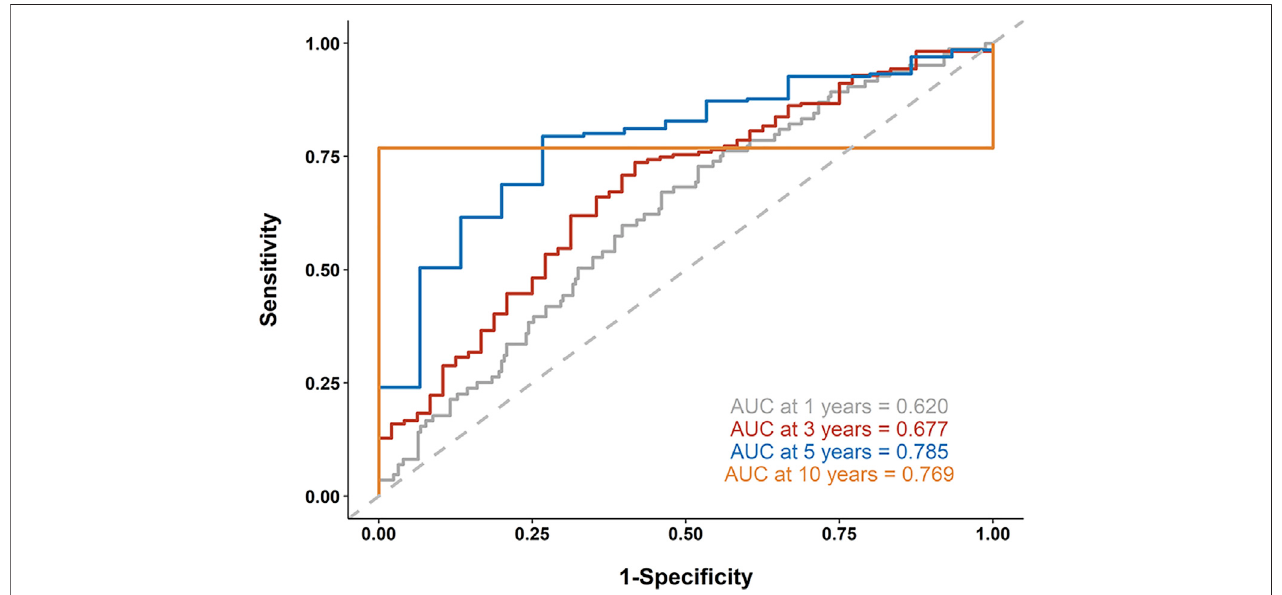
FIGURE 8 | Receiver operating characteristic (ROC) analysis. A time-dependent ROC analysis was performed to evaluate the accuracy of the 9-gene-based risk model in 1-, 3-, 5-, and 10-years prediction horizons.